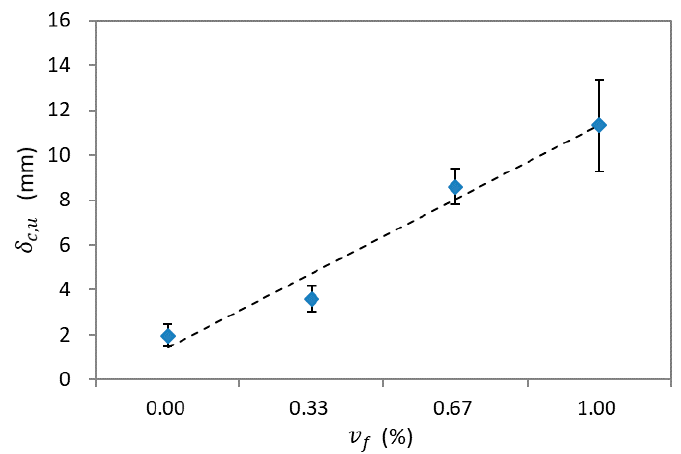
Figure 10. Displacement at the maximum shear load with increasing fiber volume percentages from zero to 1.00% .